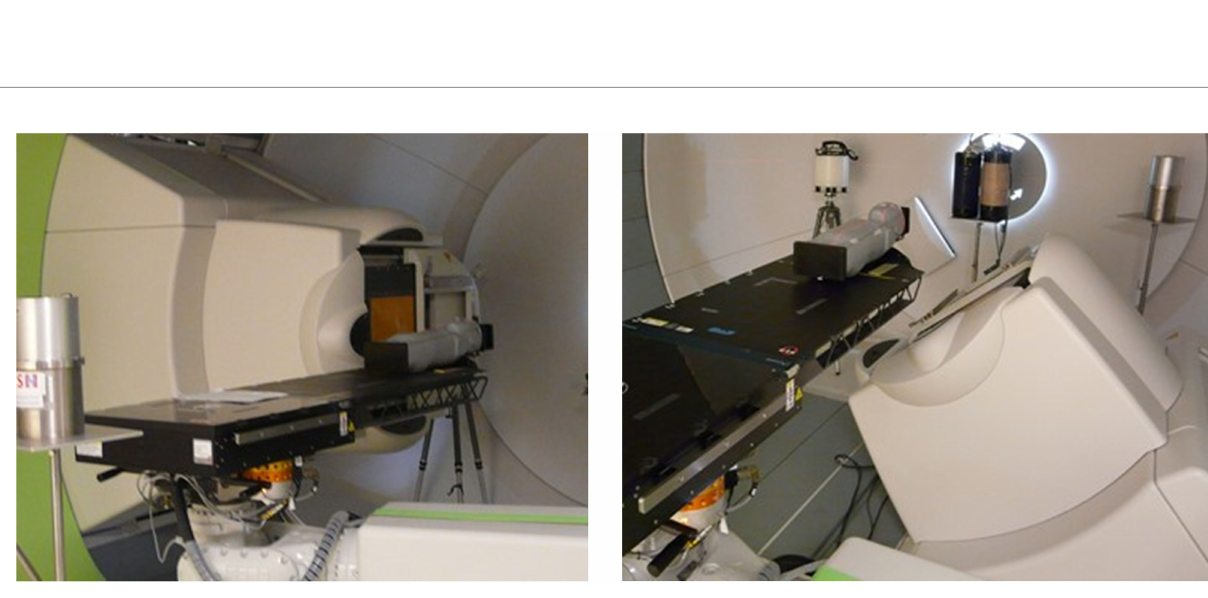
FIGURE 3 | Picture of the experimental setup within the CCB gantry room with treatment nozzle at 270° (left) and 140° (right) Photo: V.